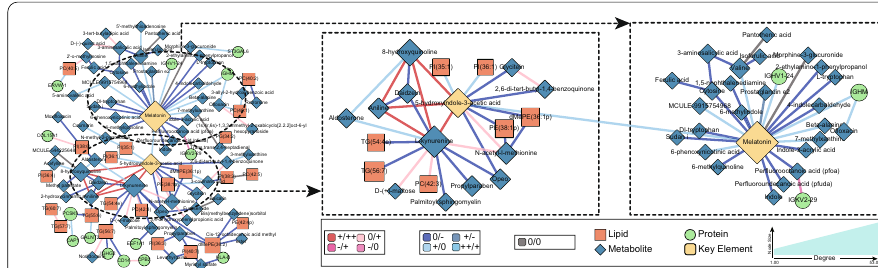
Fig. 4 Protein–metabolite–lipid multi-omics network. The network of analytes whose correlation has been converted identically in Cluster 1 vs. Cluster 2 and critical vs. severe. Nodes are colored and shaped based on the type of molecular and the size of nodes corresponds to their degree centrality. The color of edges represents the pattern of correlation changes. Crimson line / in the upper legend of the networks + ++ indicates that correlation between two connected analytes pairs was positive ( ) in critical group, and the + correlation became even more strongly positive ( ) in severe group samples, as defined by statistically ++ significant (p < 0.05) increase in correlation coefficients between the analytes pair across the two conditions. LightPink line 0/ : insignificant correlation in critical group positive correlation in severe group. DeepPink + → line / : negative correlation in critical group positive correlation in severe group. HotPink line /0: − + → − negative correlation in critical group insignificant correlation in severe group. Blue line 0/ : insignificant → − correlation in critical group negative correlation in severe group. SteelBlue line : positive in critical → ± group negative in severe group. LightSkyBlue line /0: positive in critical group insignificant in severe → + → group. DeepSkyBlue line / : more strongly positive in critical group positive in severe group. DimGray ++ + → line 0/0: insignificant correlation in critical group insignificant correlation in severe →